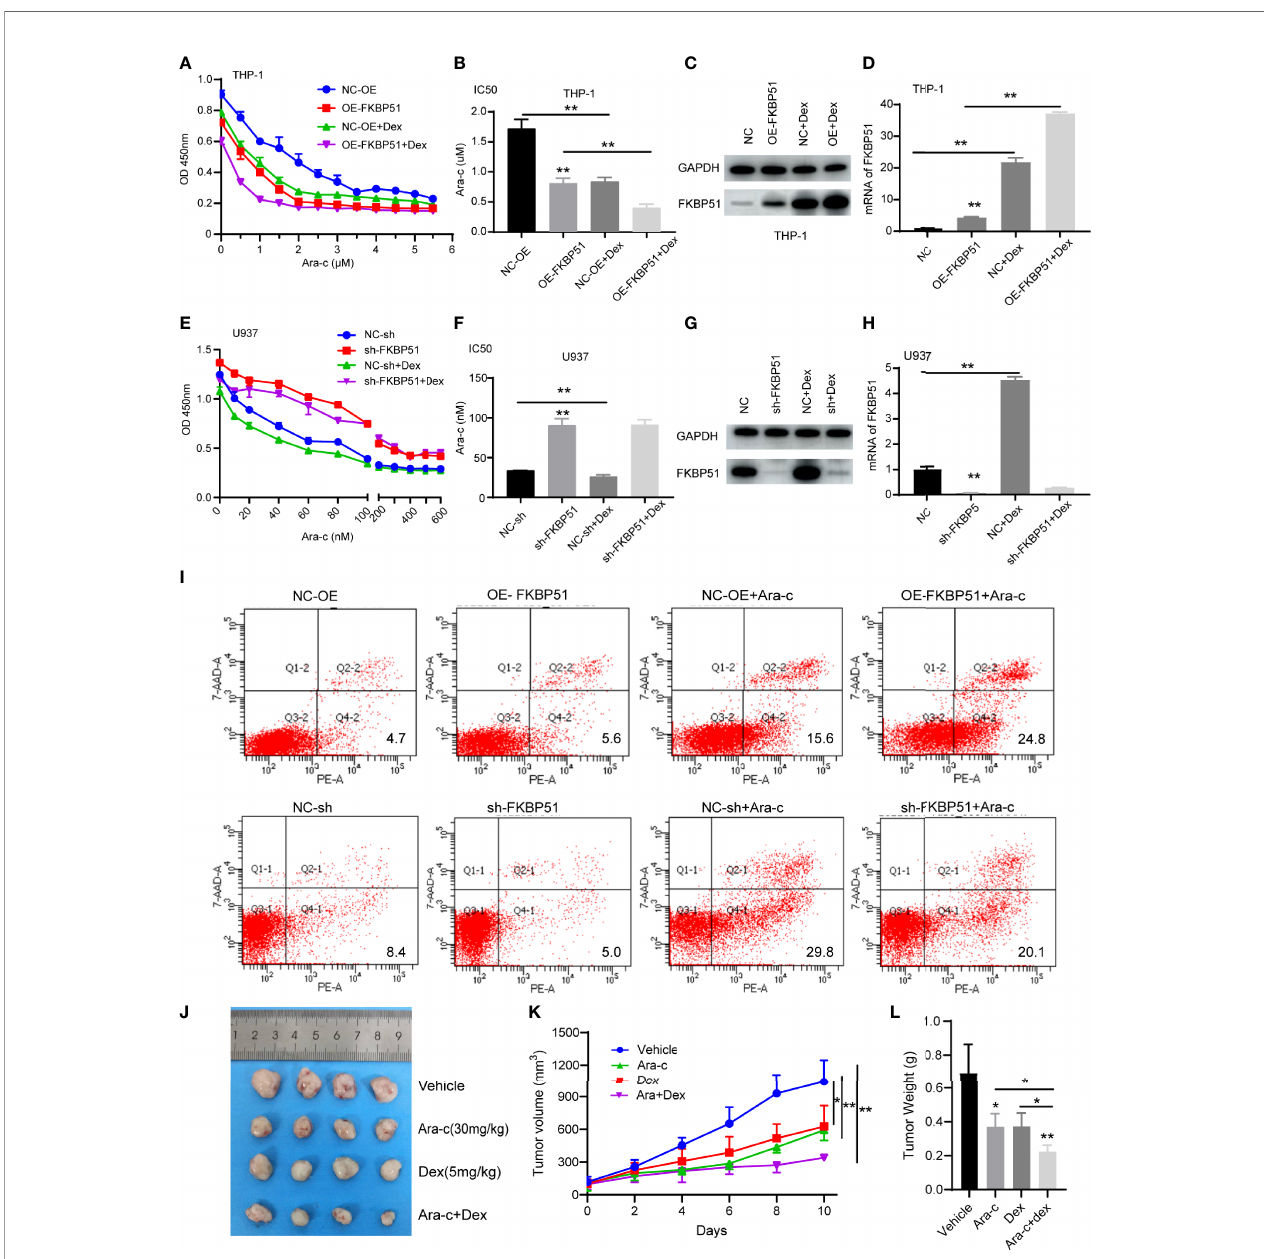
FIGURE 4 | Dexamethasone enhances the sensitivity of AML-M5 cells to Ara-C by up-regulating FKBP51. (A, E) FKBP51 enhances the sensitivity of AML-M5 cells to Ara-C. After treatment with increasing concentrations of Ara-C with or without 1 m M dexamethasone for 48 hours, the growth of FKBP51-overexpressed THP-1 cells (A) and FKBP51-knockdown U937 cells (E) and of the corresponding negative control cells was assessed by CCK-8 assay. (B, D) The corresponding IC50 values for (A, D) are shown as the mean ± SD. (C, D) Western blot and qPCR experiments were applied to detect the expression level of FKBP51 in FKBP51- overexpressed THP-1 cells after Dex (1 m M) treated for 24 h. (G, H) Western blot and qPCR experiments were applied to detect the expression level of FKBP51 in FKBP51-knockdown U937 cells and corresponding negative control cells after Dex (1 m M) treated. (I) Percent apoptosis of control and FKBP51overexpressing THP- 1 AML cells treated with or without cytarabine by FACS analysis. (F) Percent apoptosis of control and FKBP51 knockdown U937 cells treated with or without cytarabine by FACS analysis. (J-L) Dex enhanced the anti-leukemia effect of Ara-C on AML mouse xenograft model. The mice with successful tumor-forming were treated with saline (vehicle group), Ara-C (30 mg/kg/d), Dex (5 mg/kg/d), Ara-C/Dex by intraperitoneal injection. (J) Image of the tumors in vehicle, Ara-C, Dex and Ara- C/Dex four groups were recorded when the experiment ended. (K) Mean tumor volume in four groups were measured at 2 days intervals. (L) Weight of all tumors in four groups was measured after ending of administration Each experiment was performed in triplicate. Statistical differences from negative control cells are indicated by asterisks (* for p < 0.05, ** for p <